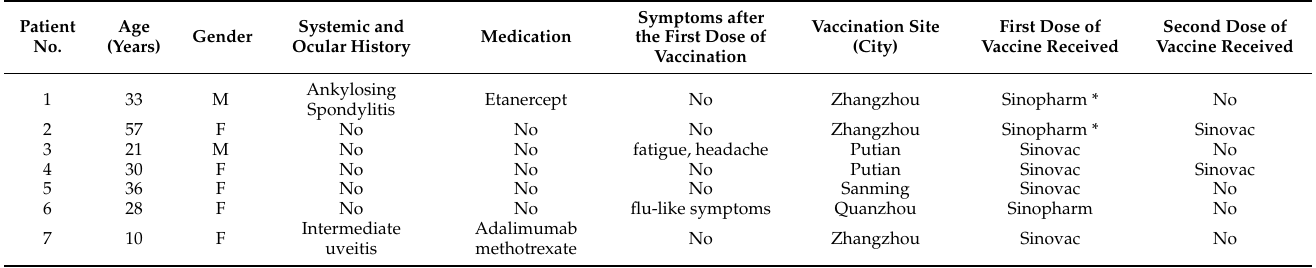
Table 1. Patients’ demographics, medical history and symptoms post inactivated COVID-19 vaccine.